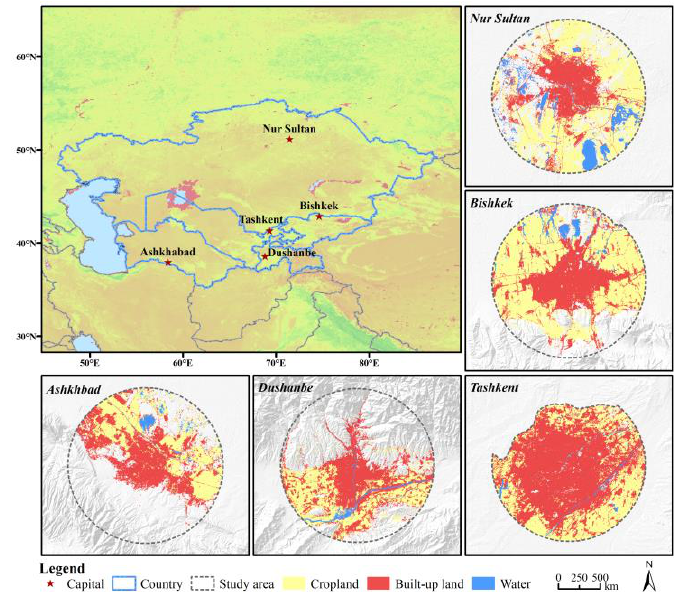
Figure 1. Locations of five Central Asian